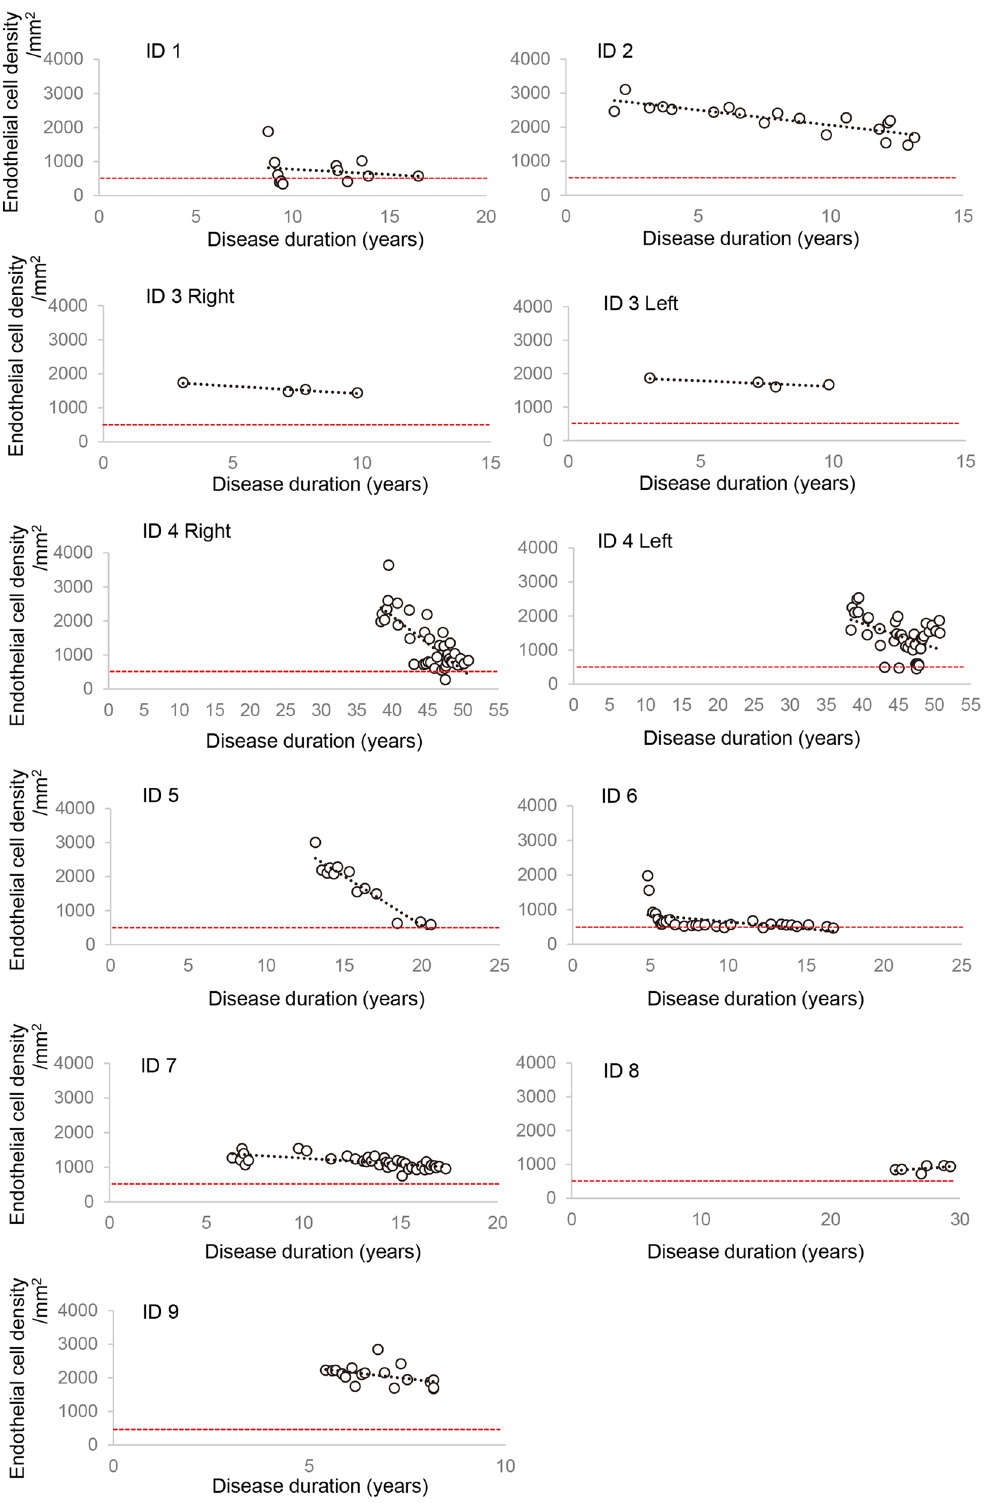
Figure 3. Corneal endothelial cell loss during the follow-up period in CMV endotheliitis patients. The corneal endothelial cell density was reduced during the long follow-up period. Red dotted line indicates endothelial cell density which represents when corneal transplantation would be necessary. All 9 cases are